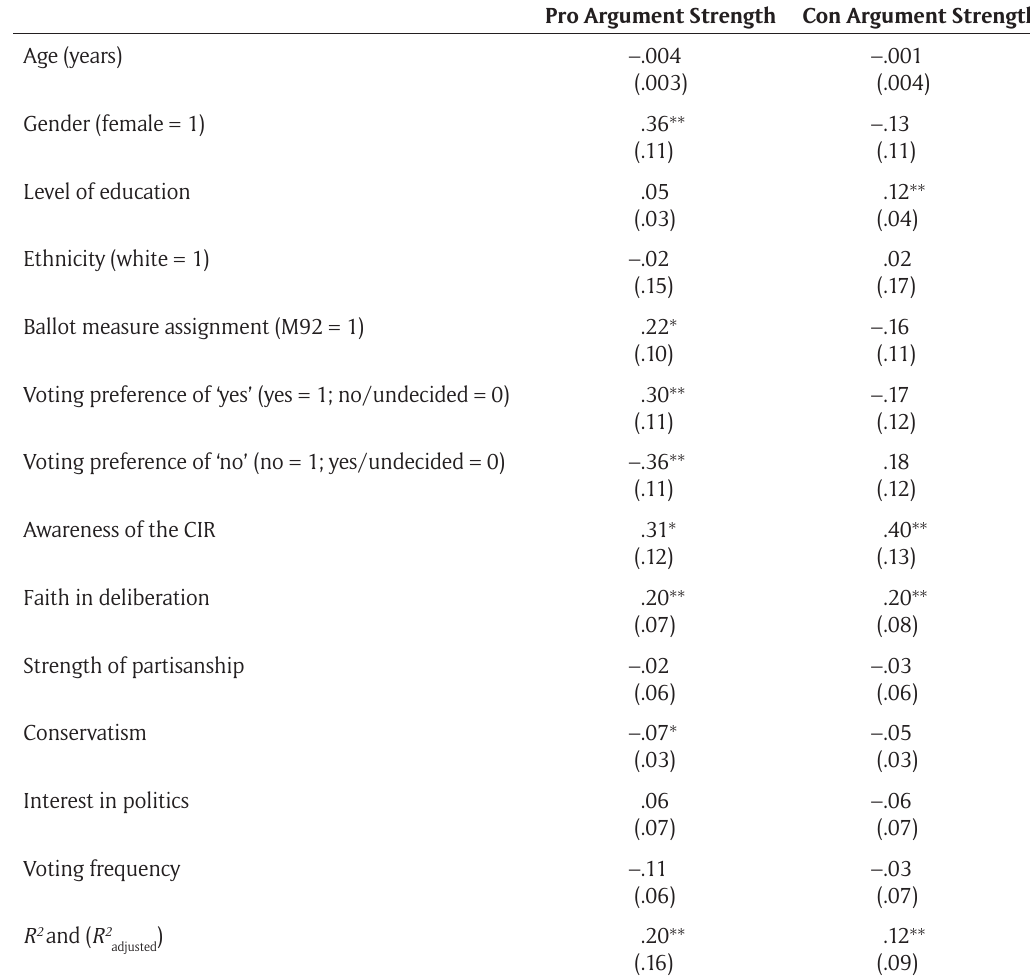
Table 4: Multiple Linear Regression Analyses for Pro and Con Argument Strength. Predictor